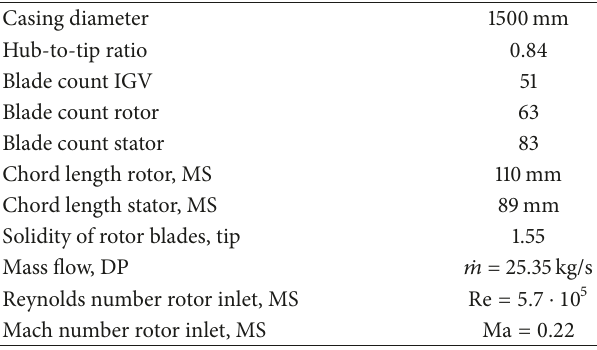
Table 1: Data of the LSRC reference build.